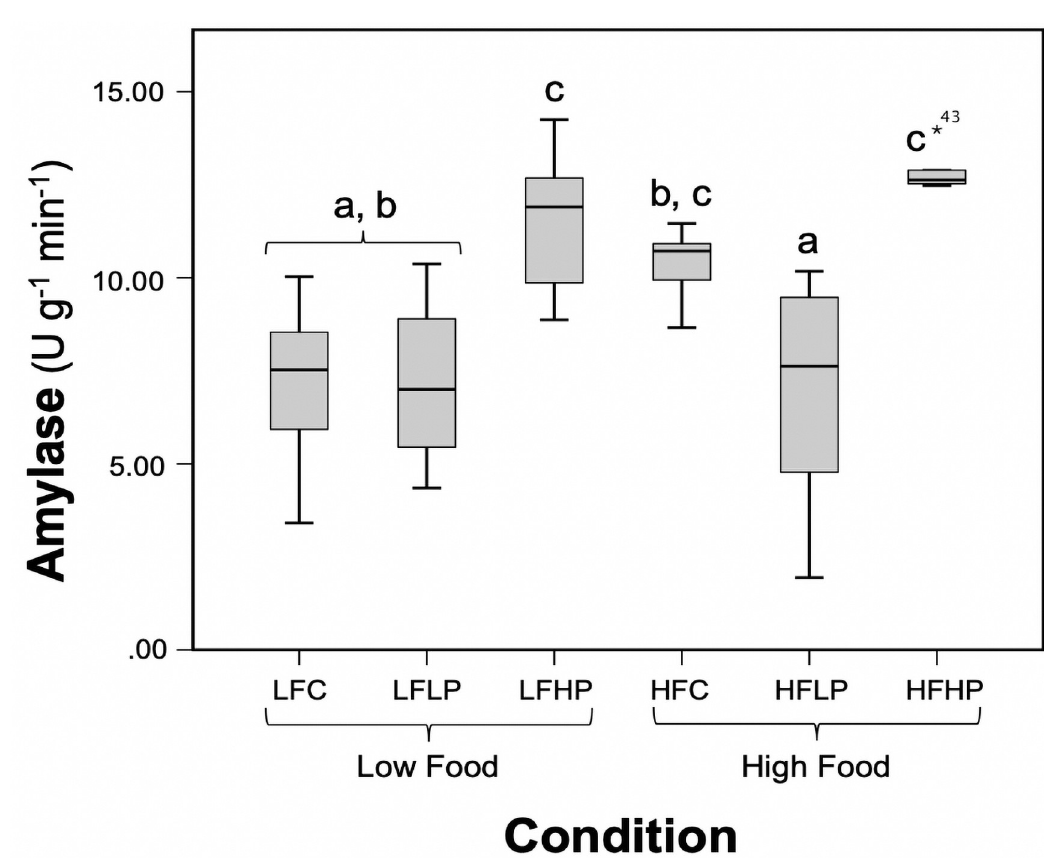
Fig 1. Variation in amylase activity in mussels between treatment groups. Tukey’s test was used to statistically illuminate variation, noted by letters. LFC = Low Food Control, LFLP = Low Food Low Plastic, LFHP = Low Food High Food Control, HFLP = High Food Low Plastic, HFHP = High Food High